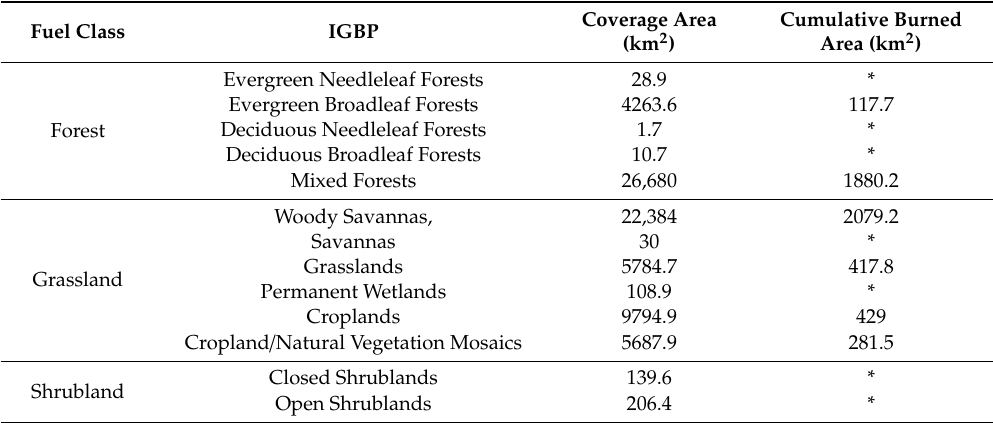
Table 1. Re-classified fuel classes based on the IGBP classification scheme and its corresponding coverage area and cumulative burned